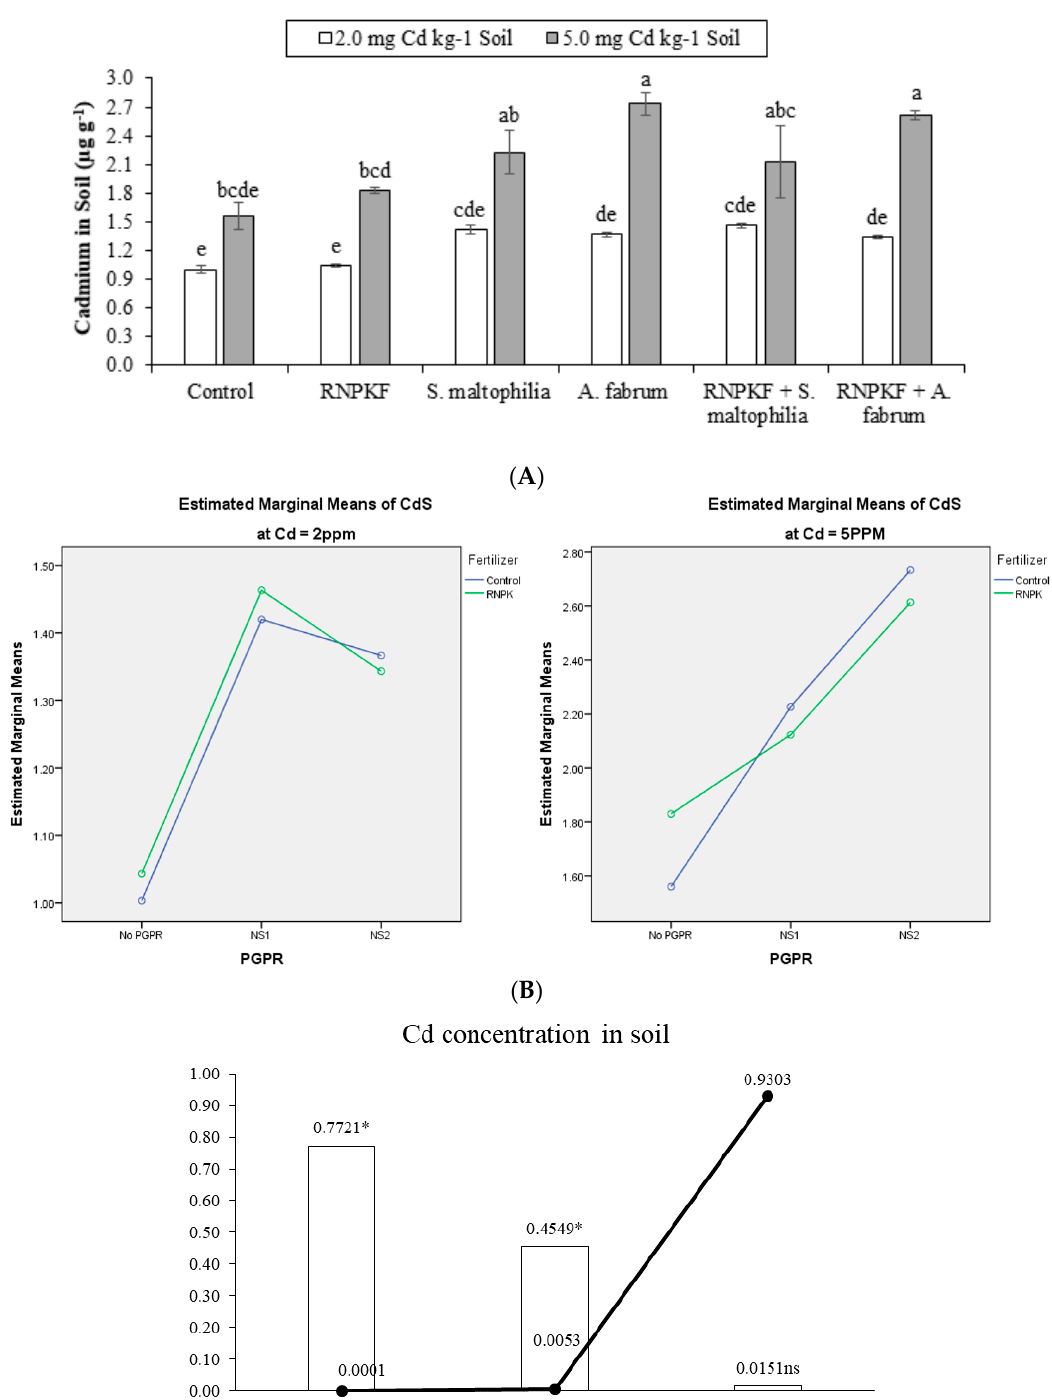
Figure 8. Effect of rhizobacteria with and without recommended NPK fertilizer on Cd in soil (CdS) under Cd ( A ). Interaction graph of PGPR (NS1 = S. maltophilia , NS2 = A. fabrum ), RNPKF, and Cd levels for CdS (µg g − 1 ) ( B ). Pearson correlation of CdS with different levels of Cd, ACCD PGPR, and recommended NPK fertilizer where the y -axis represents the values of correlation (bars in the graph) and x -axis probability (lines in the graph) ( C ). * = p ≤ 0.05; ns = p > 0.05 non-significant.